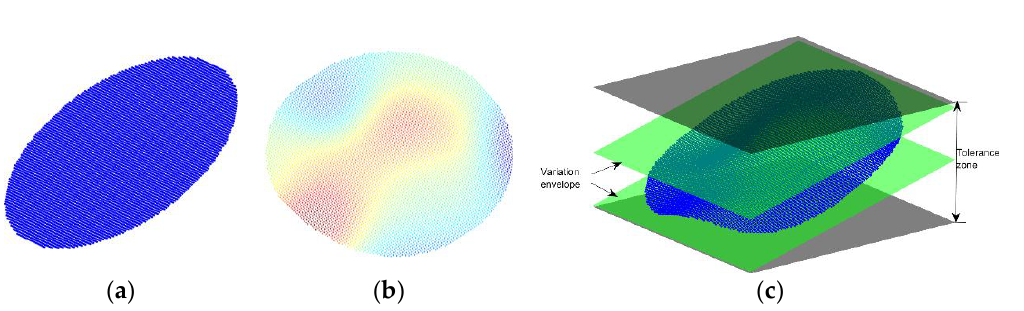
Figure 8. Summation of two surfaces ( a ) systematic deviation; ( b ) random deviations; ( c ) total deviations.